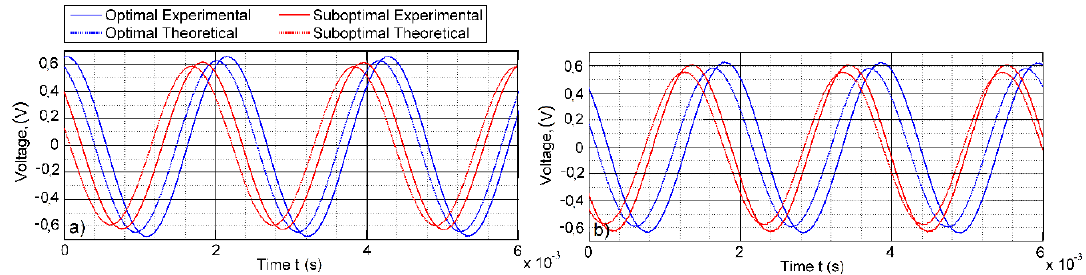
Figure 15. Experimental and theoretical outputs of total open-circuit voltage (first segment + second segment): ( a ) cantilever of a constant cross-section; ( b ) optimally-shaped cantilever.